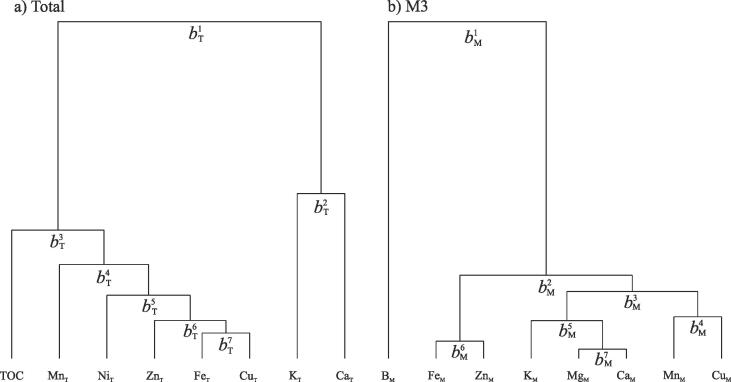
Groupings of the total (a) and M3 (b) nutrient concentration datasets derived from their respective variation matrices (see Tables S1 and S2 and Supplementary Material), used to define meaningful nutrient balances (Table 3).